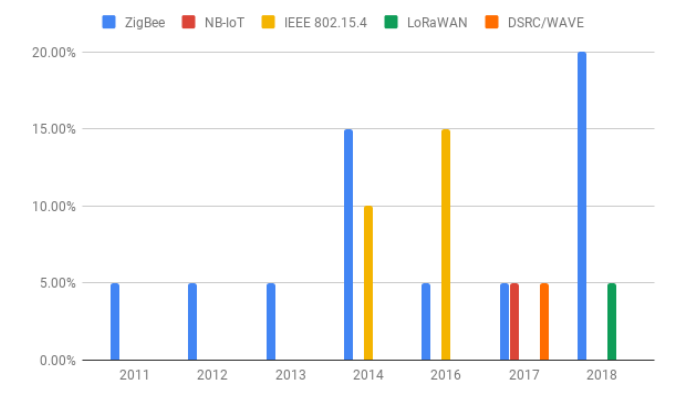
Figure 12. Detailed wireless IoT protocol usage per